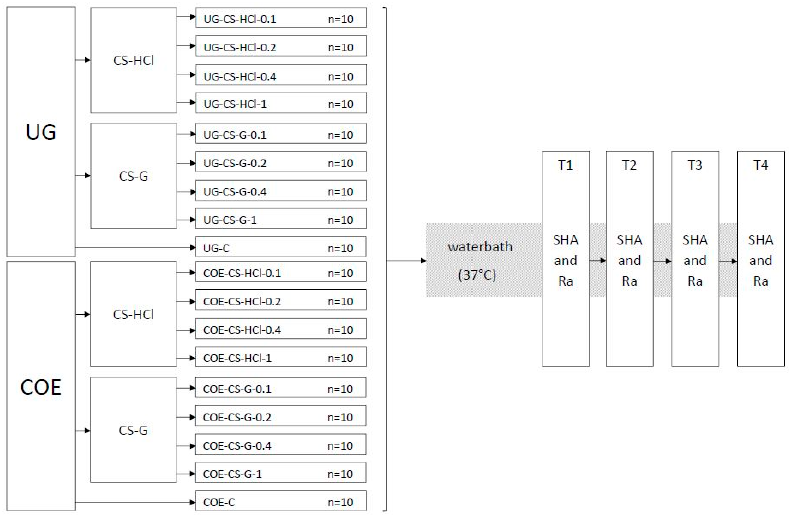
Figure 1. Flowchart of the experiment groups and testing procedure. Ufi Gel P (UG), Coe-Soft (COE), chitosan hydrochloride (CS-HCl), chitosan glutamate (CS-G), control group (C), concentration in % w/w of CS salt added (0.1, 0.2, 0.4, 1), Shore A hardness (SHA), surface roughness (Ra), 24 h after specimen preparation ( T1 ), 7 d after specimen preparation ( T2 ), 14 d after specimen preparation ( T3 ), 30 d after specimen preparation ( T4 ).